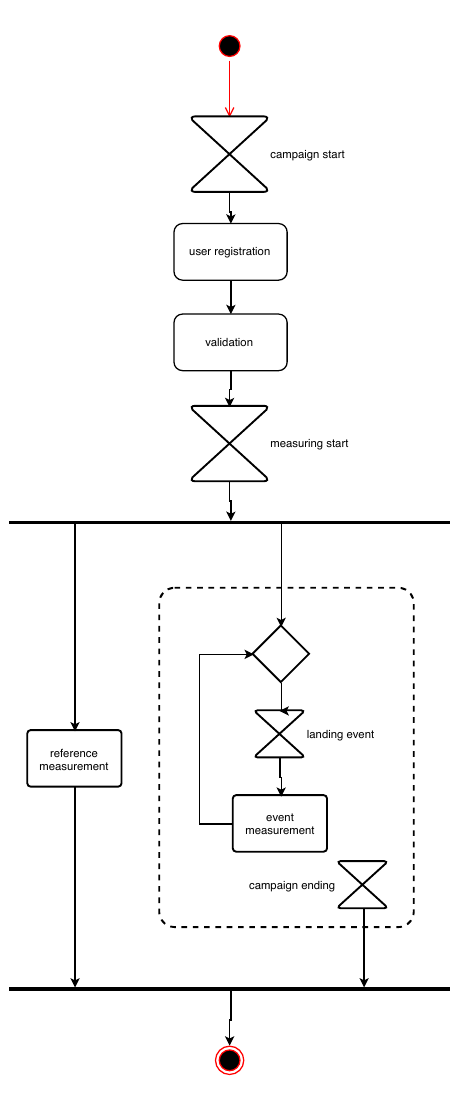
Figure 5. Activity Diagram of the NoiseCap